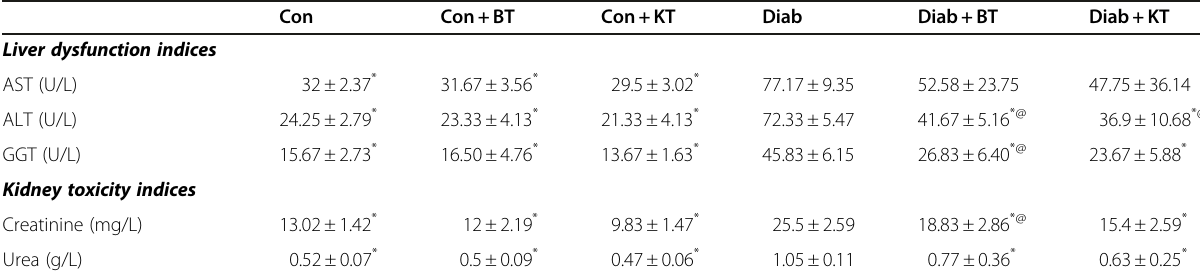
Data represent mean±S.D (n=8 for each group). The values are statistically presented as follows: single asterisk (*), p < 0.05 vs. control diabetic rats (Diab); commercial at (@), p < 0.05 vs. respective control rats (Con) [i.e. on the same corresponding tea treatment].